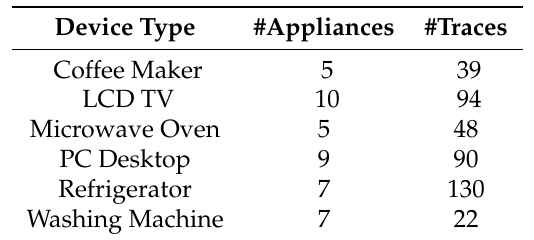
Table 4. Tracebase subset of appliances used in our approach. Data have been partially reproduced from